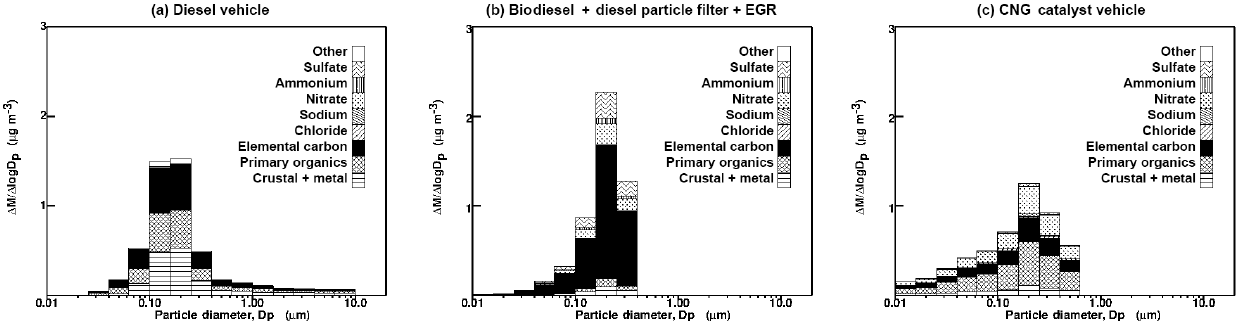
Figure 6. Particle emissions size and composition distribution for diesel vehicles (a) , biodiesel vehicles (b) , and CNG catalyst-equipped vehicles (c) .